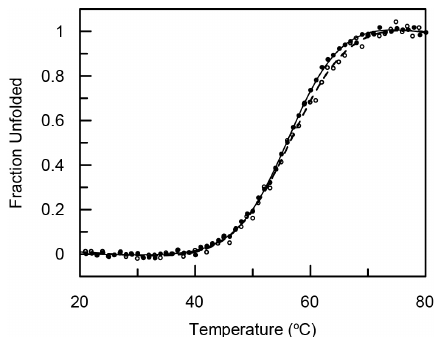
Figure 3. Normalized thermal denaturation (black line) and renaturation (dashed line) of (Z HER2:4 ) 2 DCS monitored by ellipticity changes.